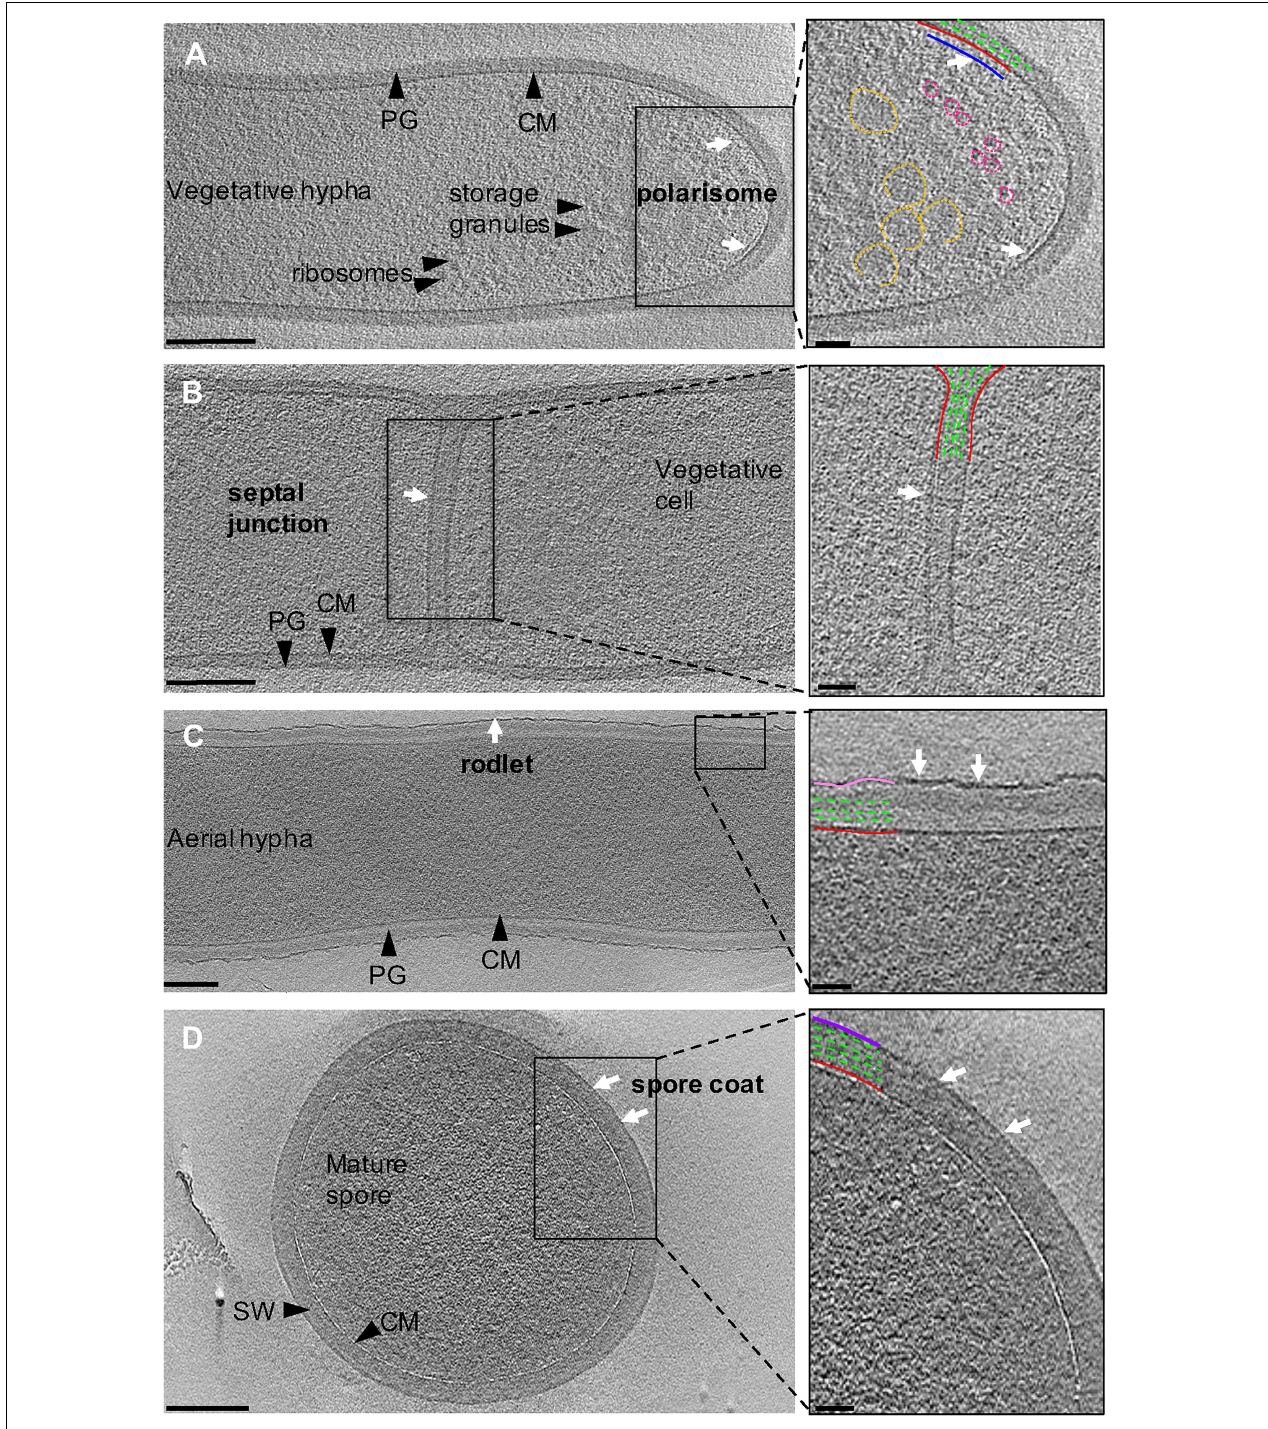
FIGURE 3 | Ultrastructure of Streptomyces . Tomographic slices through S. albus cells at different stages of sporulation. (A) Vegetative hypha. The cytoplasmic membrane and peptidoglycan are shown in red and green, respectively. Putative features include: polarisome (blue, white arrows), glycogen storage granules (yellow), and ribosomes (pink). (B) Vegetative septum between two neighboring cells. A putative septal junction is highlighted with white arrows. (C) Aerial hypha reveal the expected rodlet layer on the surface (pink, white arrows). (D) Mature spore surrounded by a 10-nm thick layer, supposed to be a spore coat (purple, white arrows) on the surface of the spore wall (SW). Insets show a magnified image of the boxed areas. Scale bar = 200 nm, inset 50 nm.